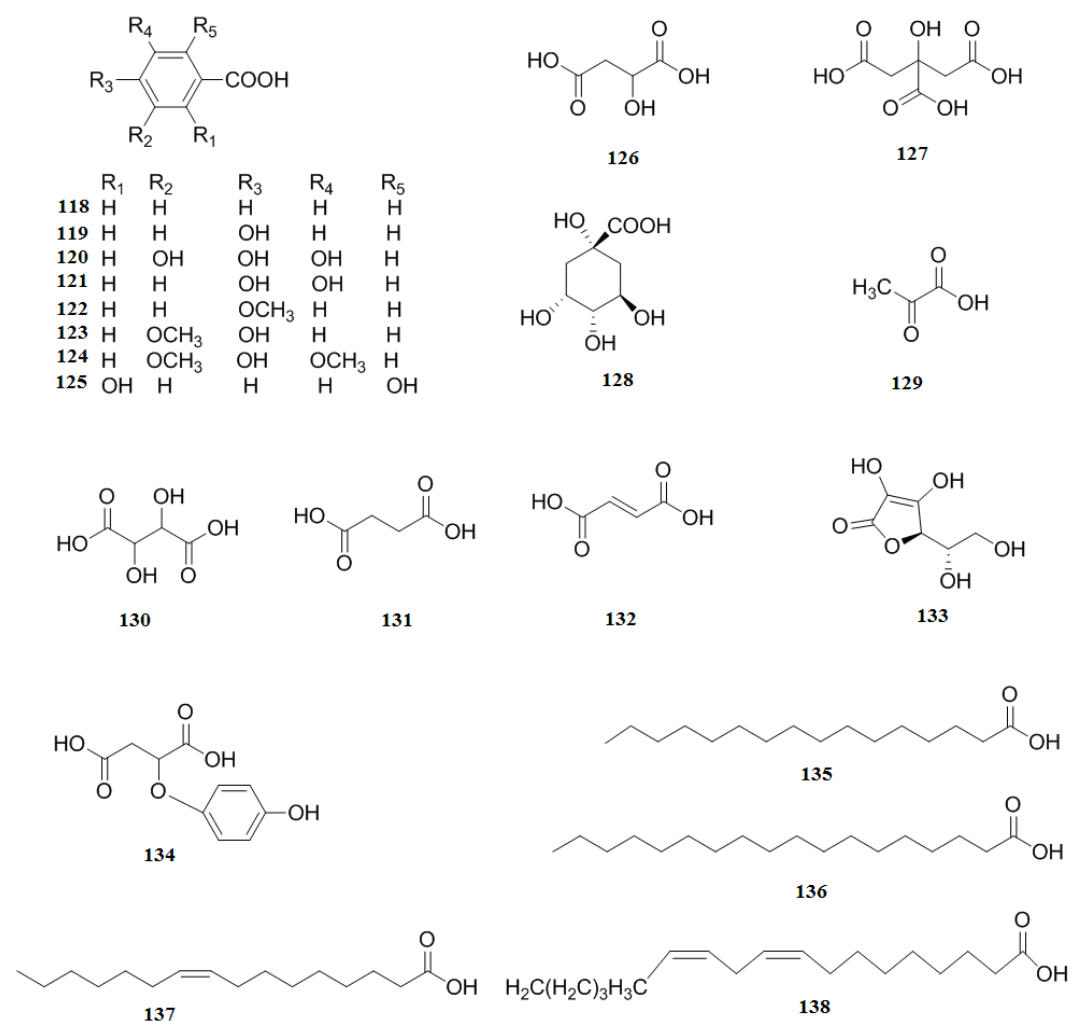
Figure 10. Chemical structures of organic acids in C. pinnatifida